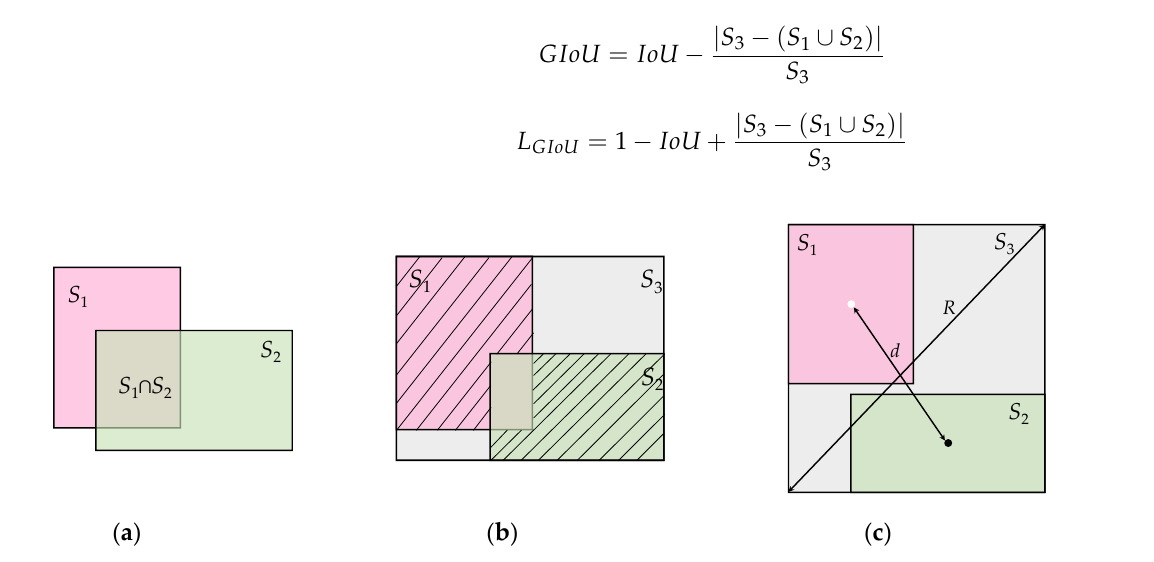
as shown in Figure 8b. Firstly, it is necessary to find the smallest box S 3 that completely wraps S 1 and S 2 , and then the area not occupied by the two boxes in S 3 is calculated as: